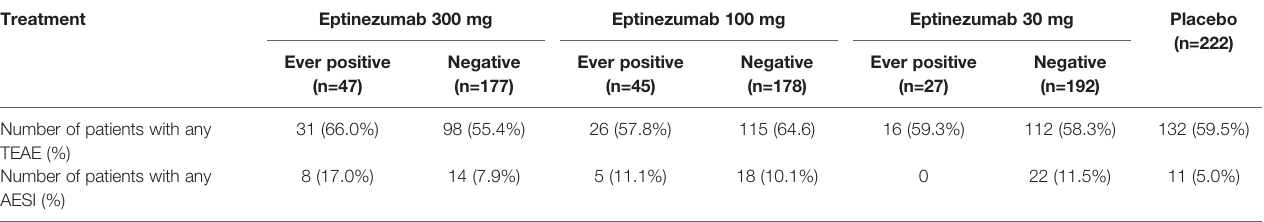
TABLE 7 | Summary of TEAEs and AESIs by anti-eptinezumab antibody (ADA) status for PROMISE-1. Treatment